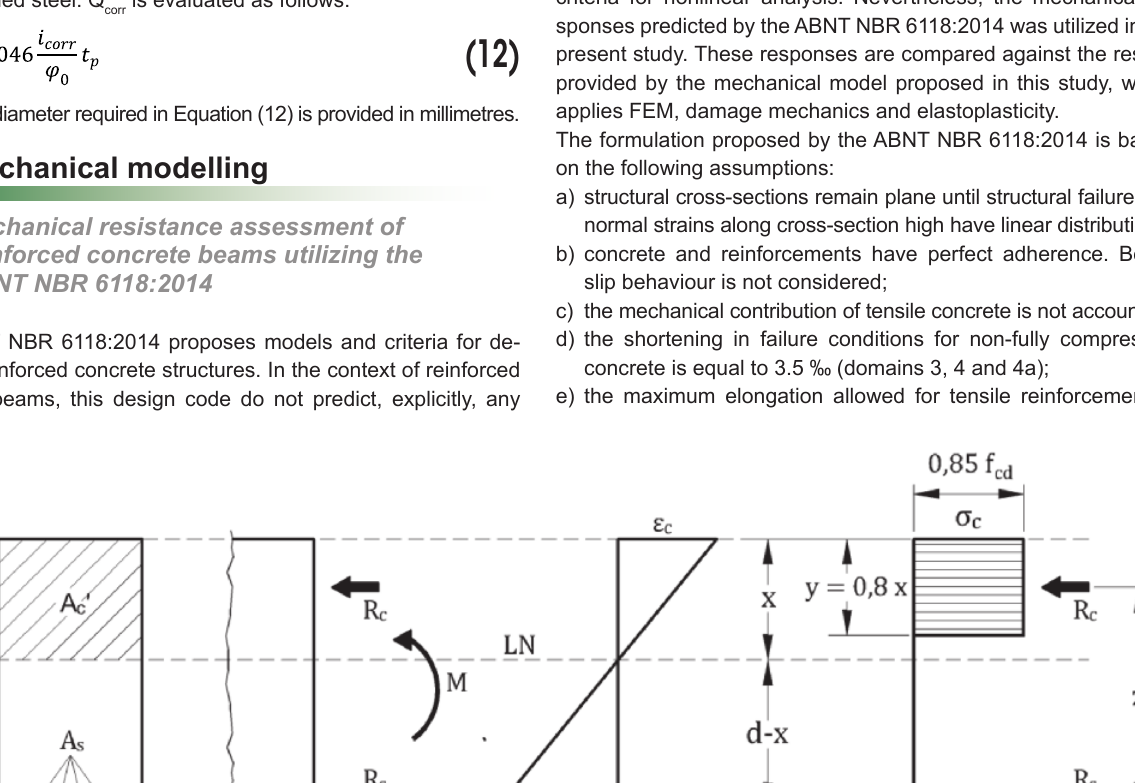
Evolution of the corrosion rate along time (t considering w/c of 0.5